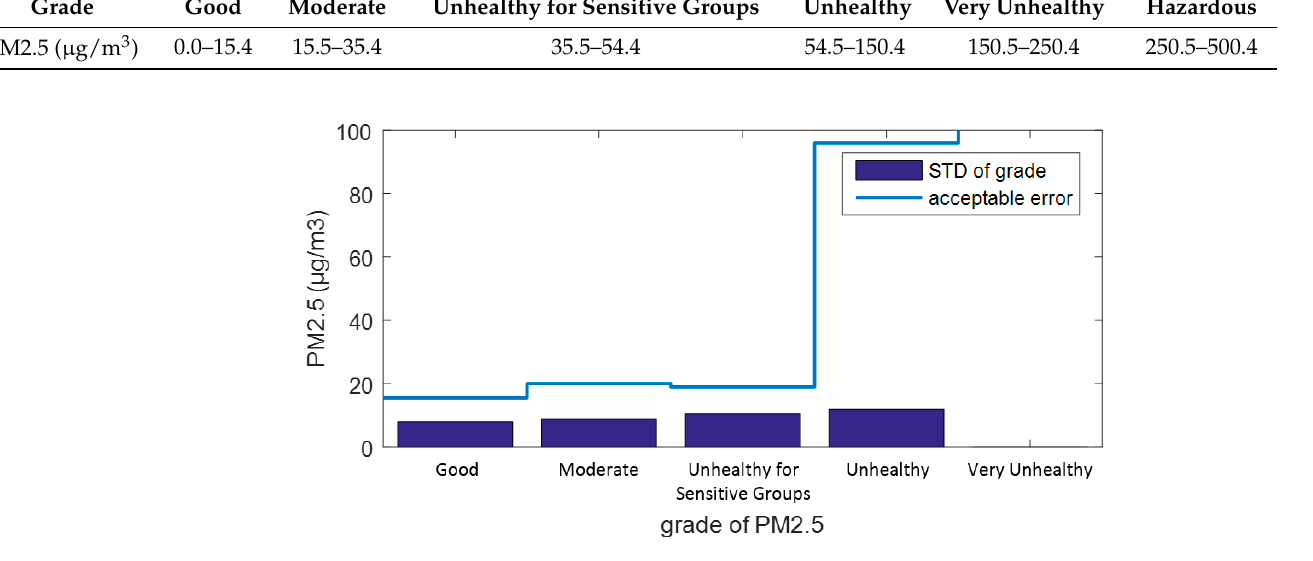
Figure 15. Acceptable error and each grade’s standard deviation from our results.